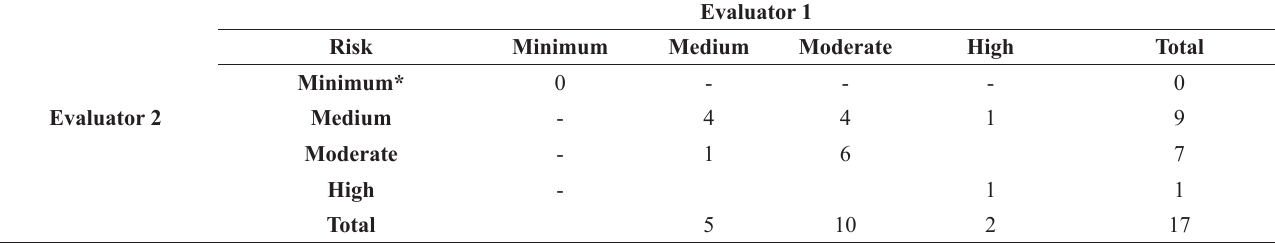
Table 5 - Table 4x4 (inter-rater agreement)